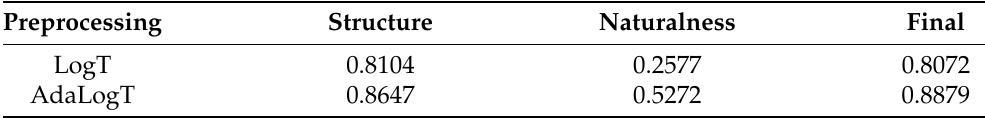
Figure 11. TMQI final score of the gradient-domain algorithm in different preprocessing methods. Table 3. Mean TMQI scores of gradient-domain algorithm.